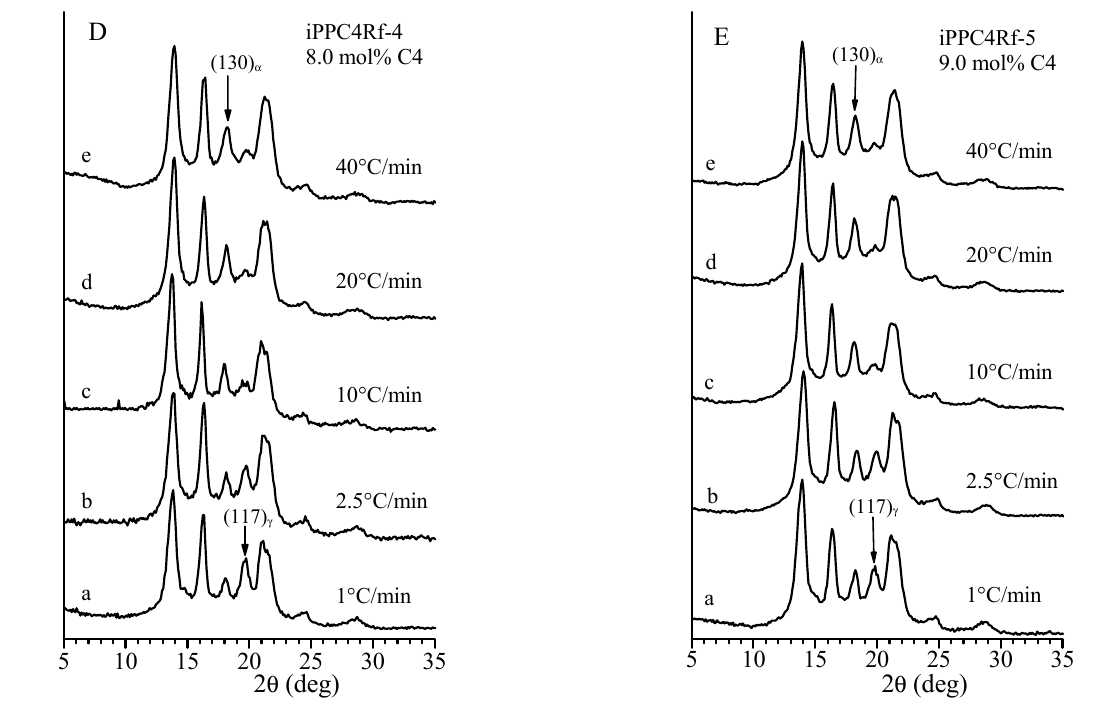
Figure 6. X-ray diffraction profiles of samples of copolymers iPPC4Rf-x crystallized from the melt by cooling the melt from 170 °C down to 25 °C at the indicated different cooling rates.